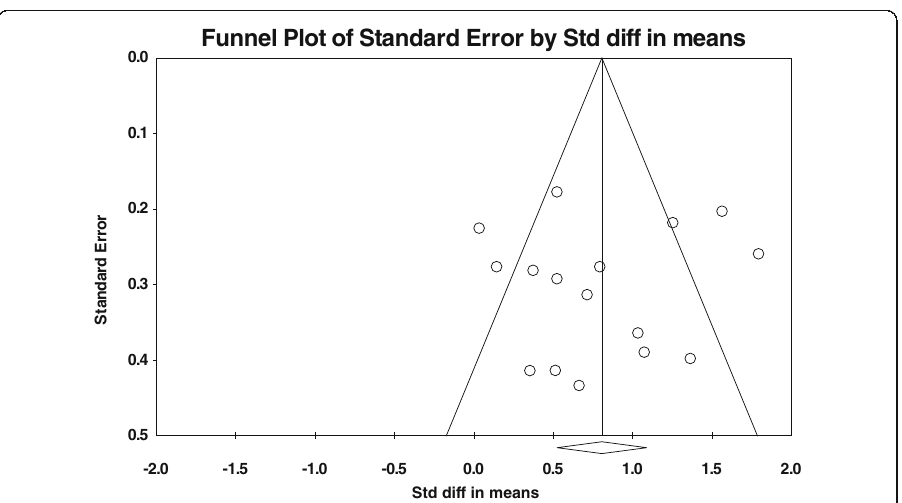
Fig. 2 Publication bias: Funnel plot to assess publication bias